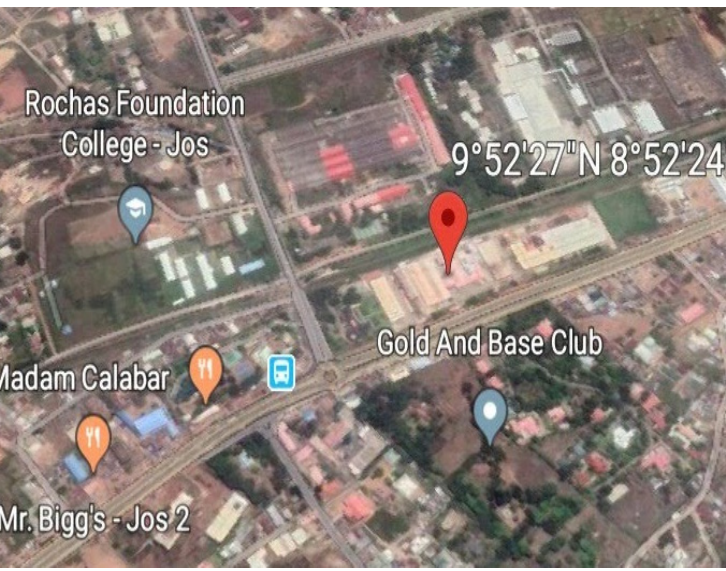
Figure 2. Google Earth (2019) Satellite Map Showing NHPL Jos Plateau State Nigeria. Table 1. Information of the Monitored Workstations NHPL.